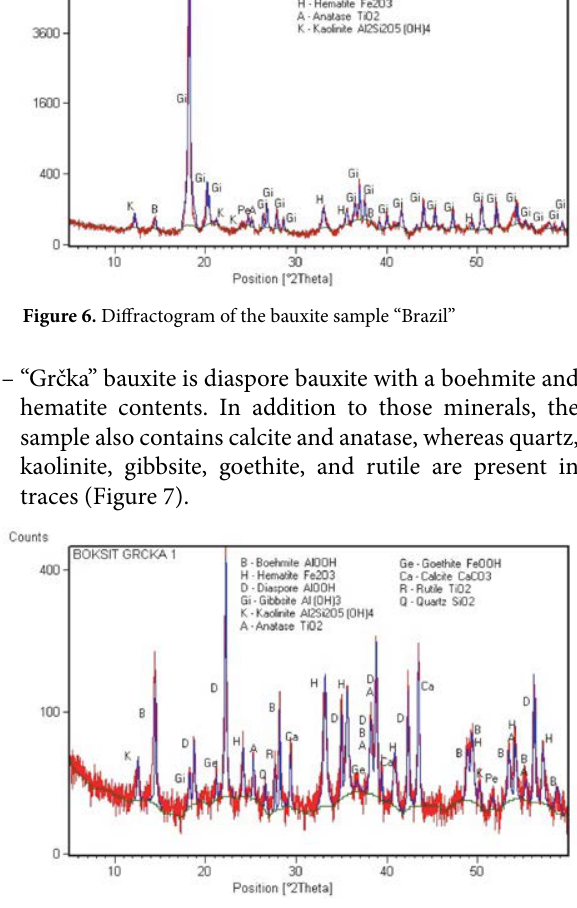
Figure 7. Diffractogram of the bauxite sample “Grčka” – “Mađarska” is a gibbsite-boehmite combination with he- matite and kaolinite contents. In addition to these min- erals, the sample also contains goethite and traces of ana- tase and rutile (Figure 8).